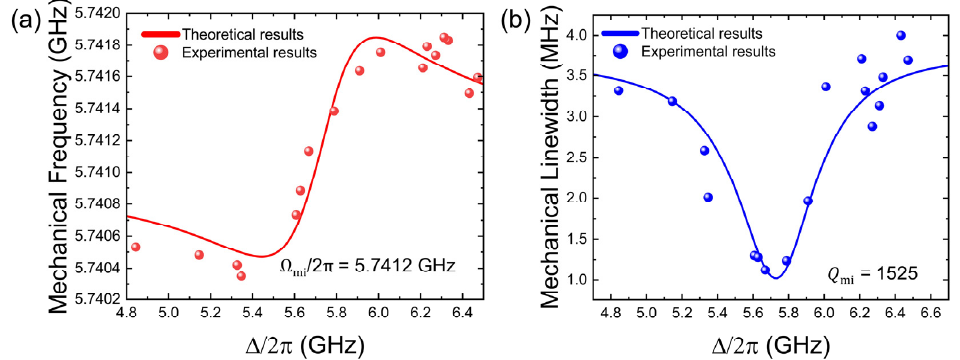
Figure 6. ( a ). Mechanical resonant frequency Ω /2 π and ( b ). mechanical linewidth γ /2 π versus cavity detuning Δ for input power P in = − 0.34 dBm. detuning ∆ for input power P − 0.34 in =